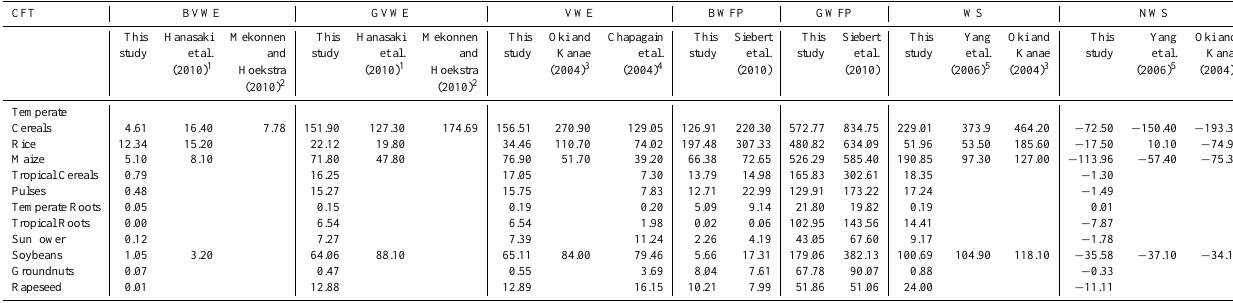
Table A1. Comparison of VWE, WFP, WS and NWS with other estimates. All values in km 3 . CFT